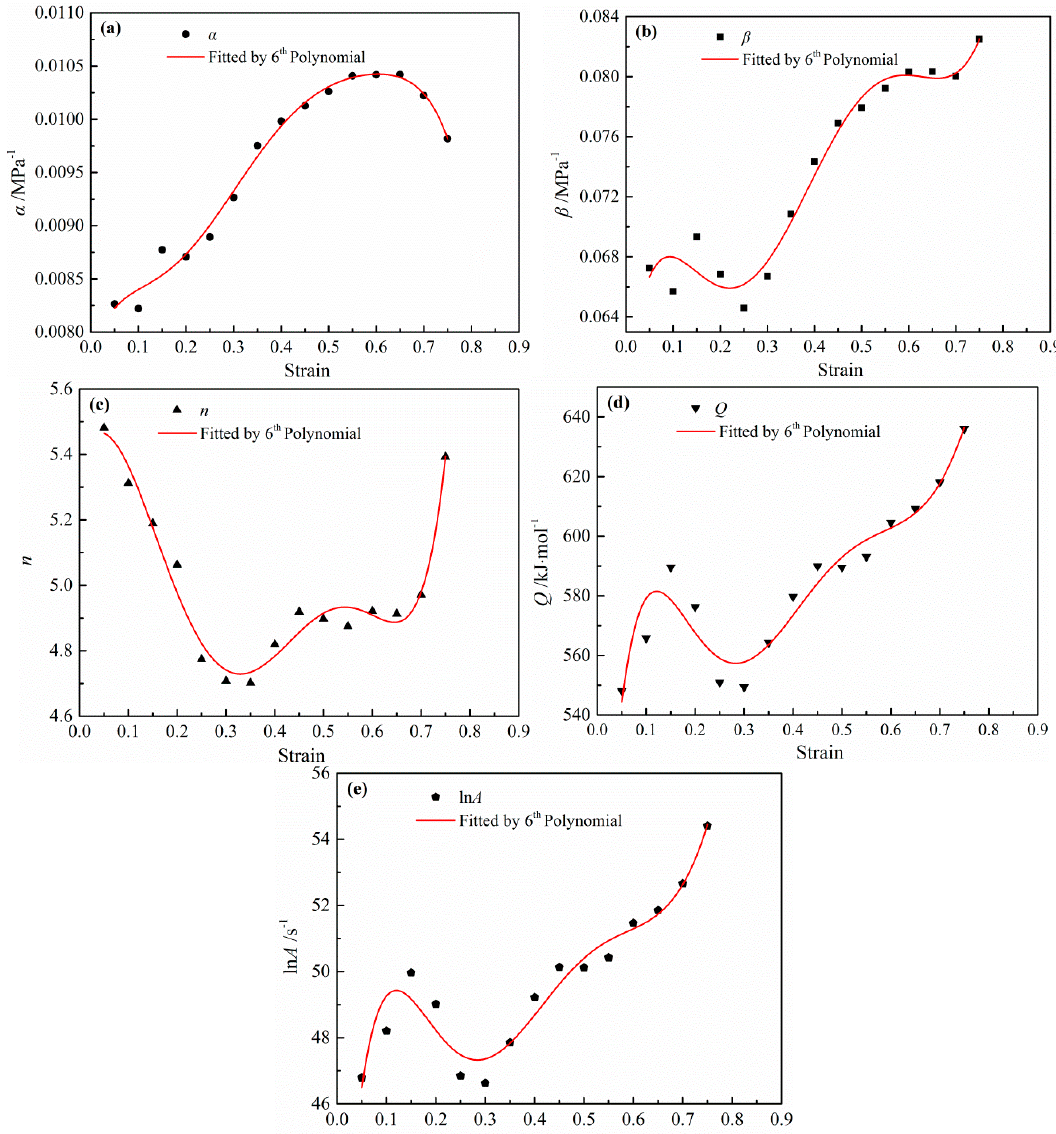
Figure 11. Relationship between material constants and strains: ( a ) α ; ( b ) β ; ( c ) n ; ( d ) Q ; ( e ) ln A . Once the polynomial coefficients of all material constants were evaluated, the flow stress at a particular true strain can be estimated. Using the expression of hyperbolic sine function, the constitutive equation that relates to flow stress and the Zener ‐ Holloman parameter can be written in the following form [48]: